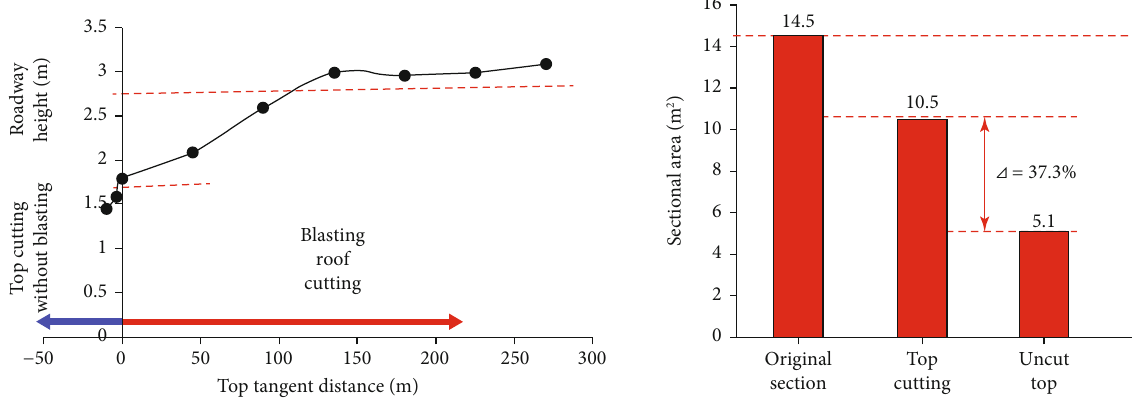
Figure 14: Display of deformation data of surrounding rock along the empty roadway before and after cutting the